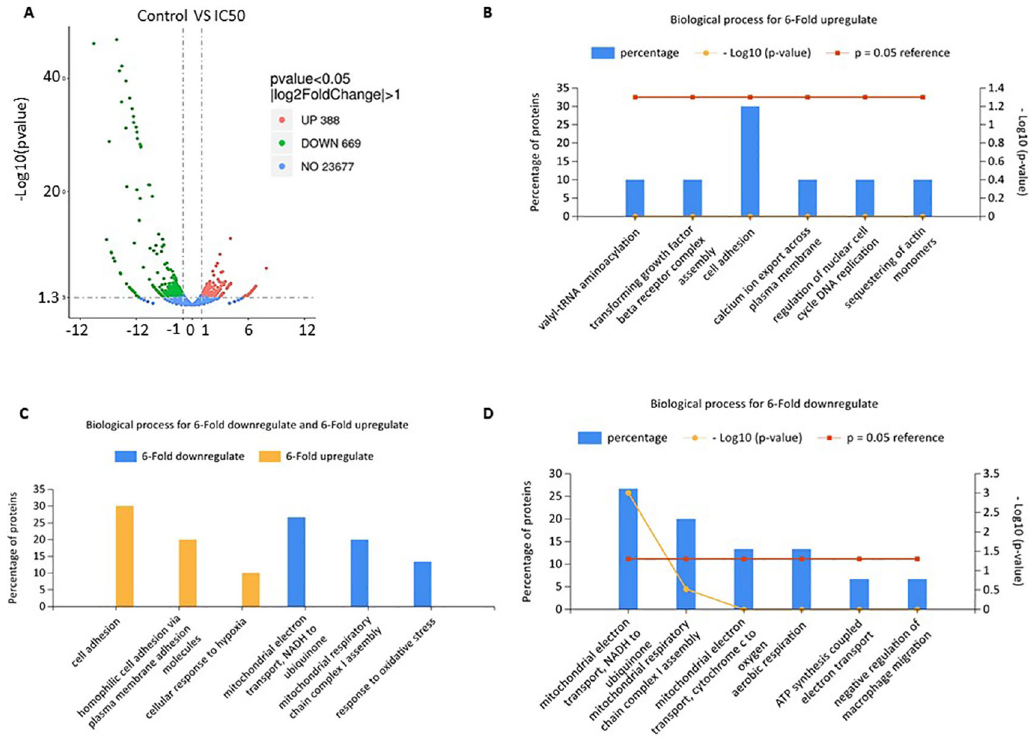
Figure 3. Gene expression profile affects the biological processes of A549 cells after C. sappan extract treatment for 24 h. (A) Volcano plot; (B) biological processes for sixfold upregulation; (C) biological processes for sixfold up- and downregulation; (D) biological processes for sixfold downregulation.